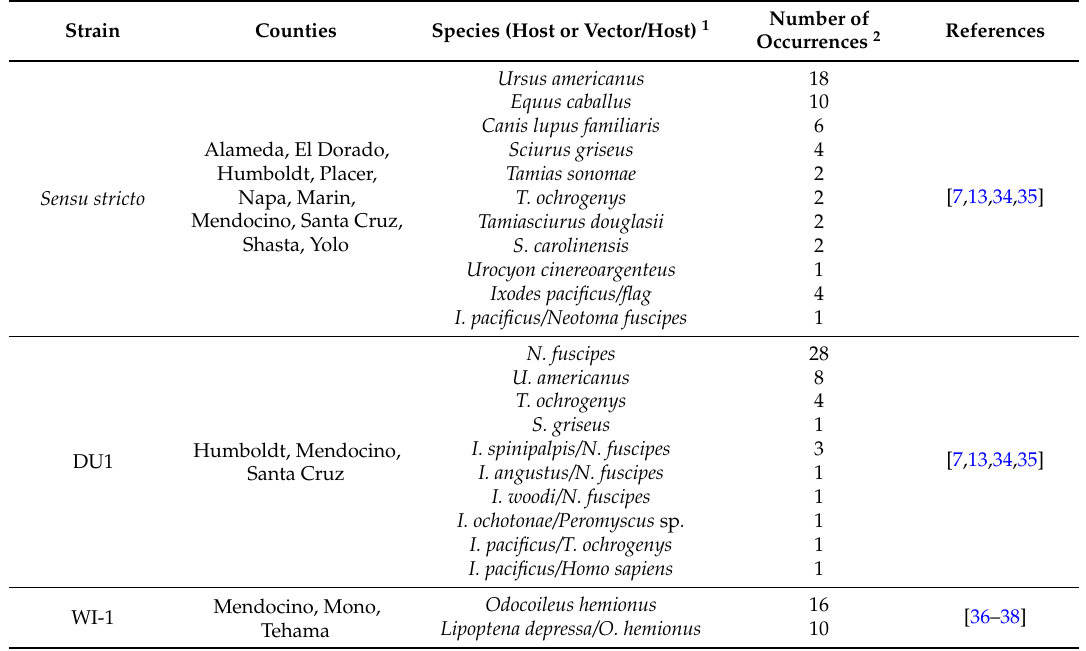
Table 1. List of strains within the Anaplasma phagocytophilum sensu lato complex in California, their distribution, host and vector range, and number of times each has been